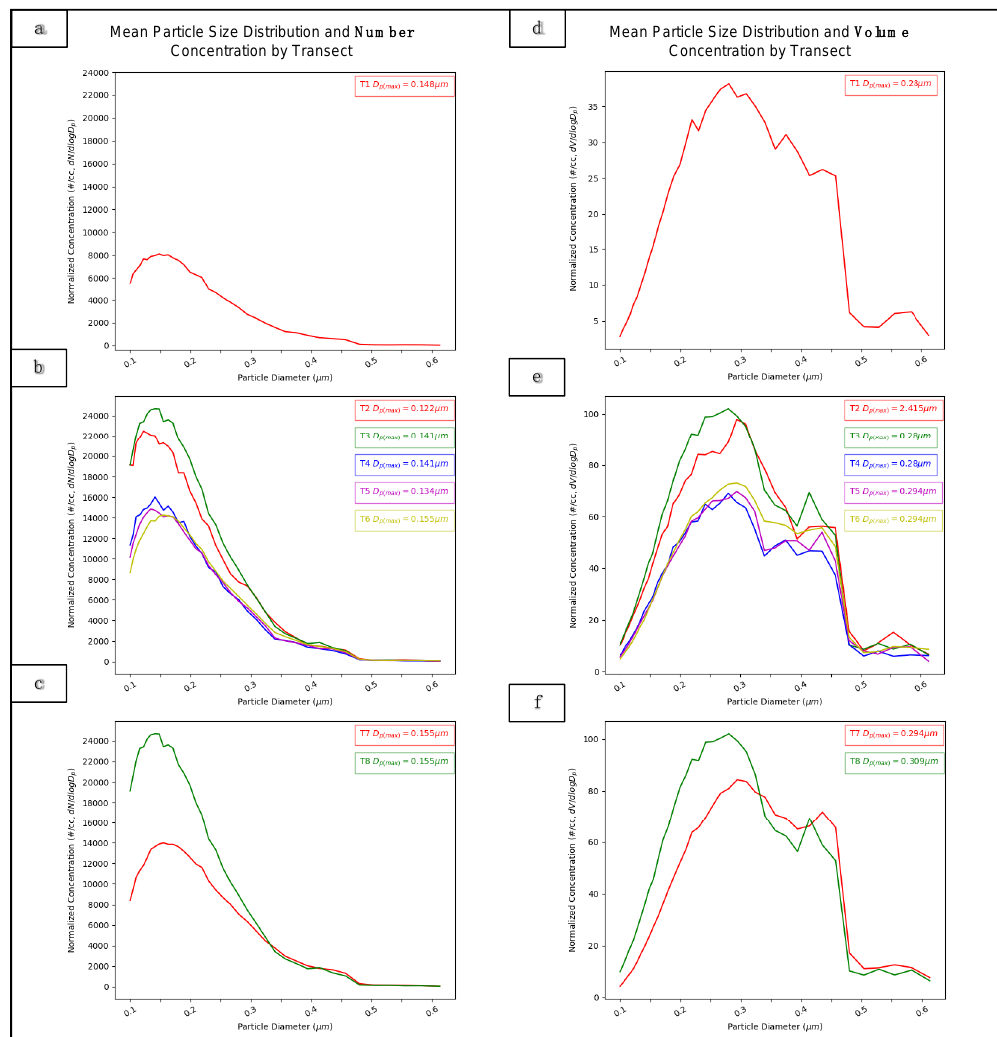
Figure 9. Mean particle number ( a – c ) and volume ( d – f ) concentrations and size distributions for each transect observed by the FIREX aircraft (from the LAS instrument), where ( a ) includes transect 1 and samples the downwind end of Region I, ( b ) includes transects 2 through 6, corresponding to Region II, and ( c ) contains transects 7 and 8 that observed Region III. The mode aerosol diameter for each transect is provided as well, where box and text color are matched with the corresponding transect color.